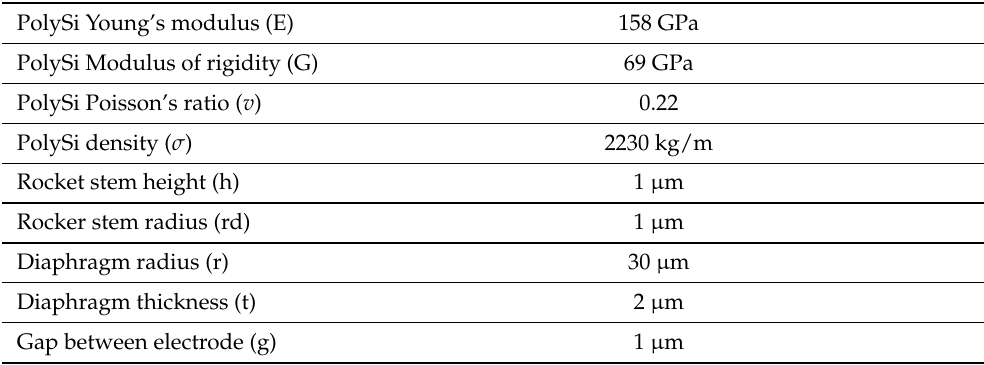
Figure 7. CMUT A and B cross-section. Table 3. Material properties and dimensions of the novel